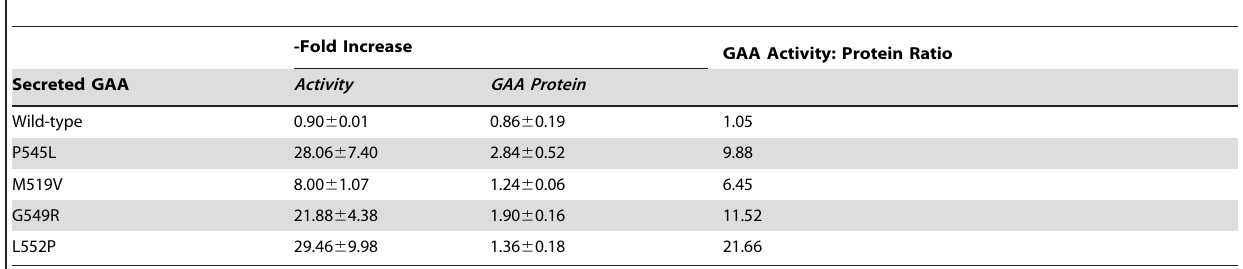
Table 1. Effect of AT2220 incubation on enzyme activity and protein levels of secreted wild-type and mutant GAA.